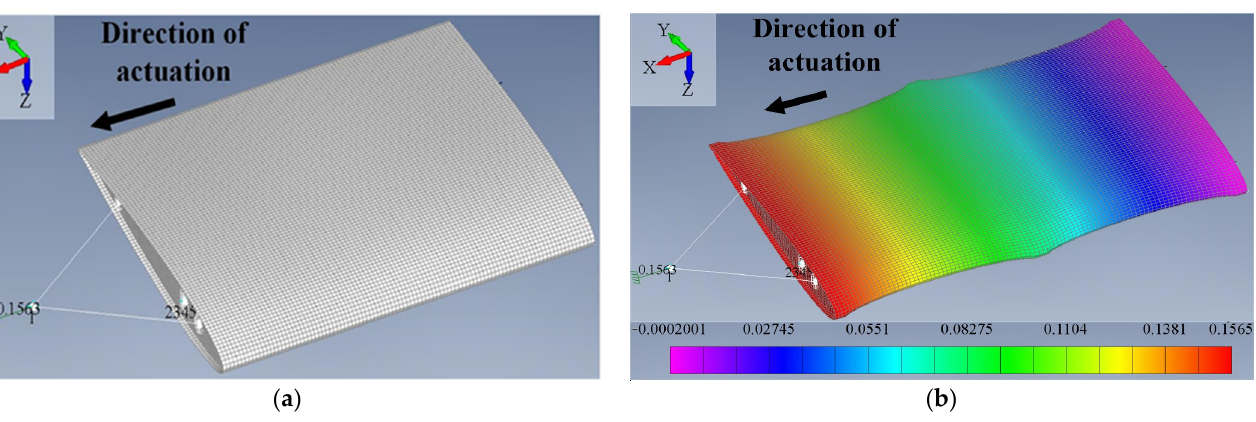
Figure 9. Femap model of inboard segment pre- and post-25% span extension (in meters): ( a ) Before span extension. ( b ) After span extension.